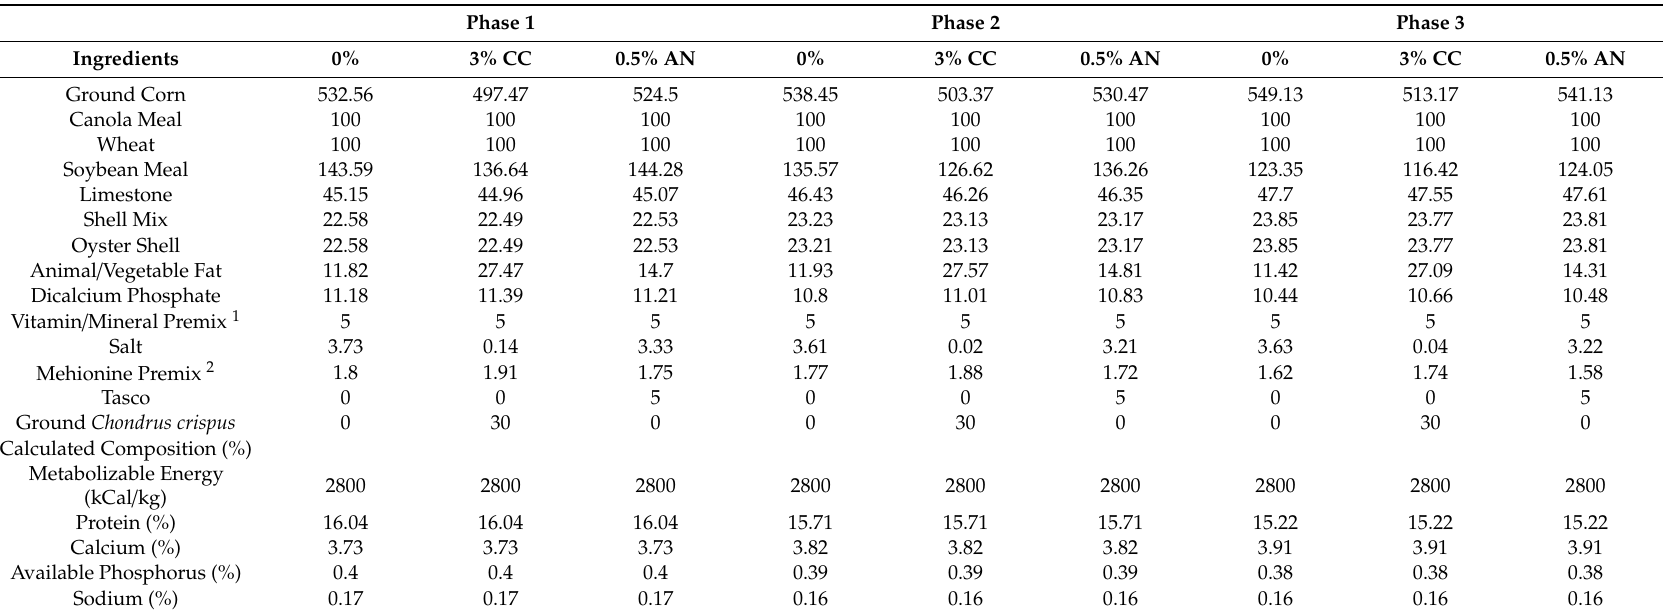
Table 1. Diet formulation (g / kg) and calculated composition (as the fed basis) of the laying diet